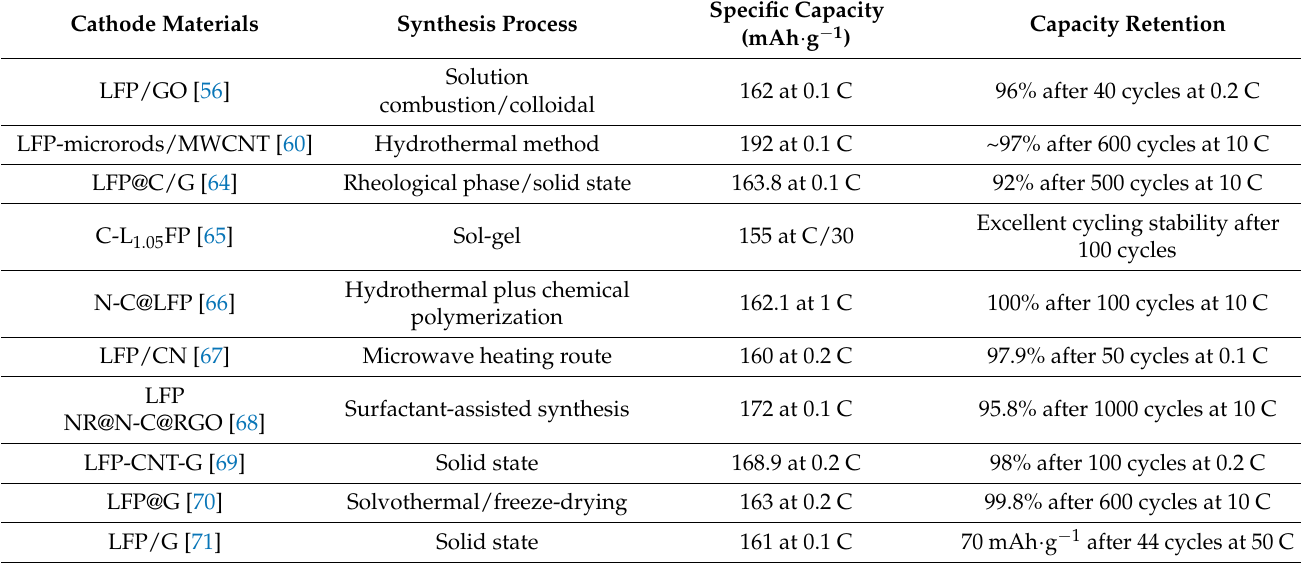
Table 4. Comparison of electrochemical performance of cathode materials using different growth